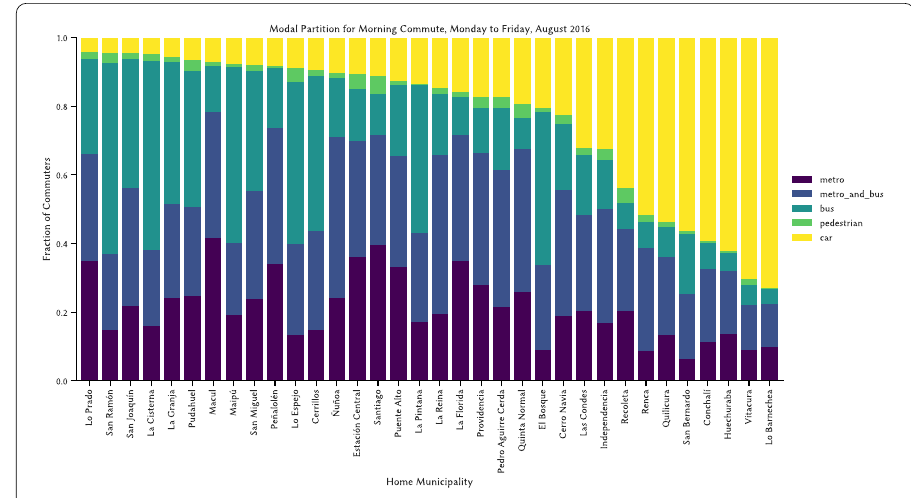
Figure 12 Relative distribution of XDR-inferred mode of transportation usage ( modalpartition ) per home municipality in Santiago. The municipalities are sorted with respect to car usage